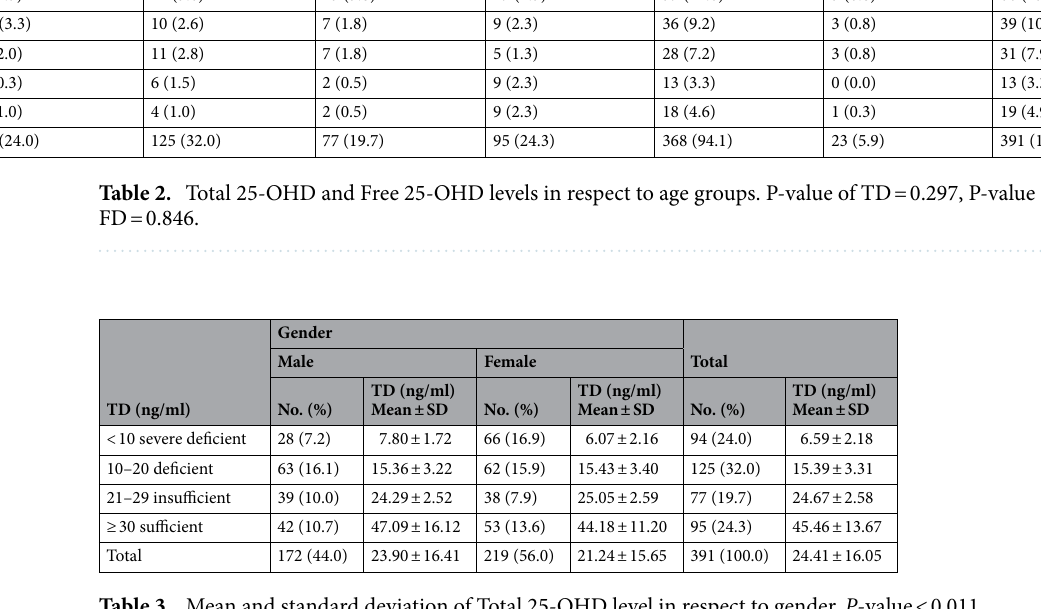
Table 3. Mean and standard deviation of Total 25-OHD level in respect to gender. P -value <